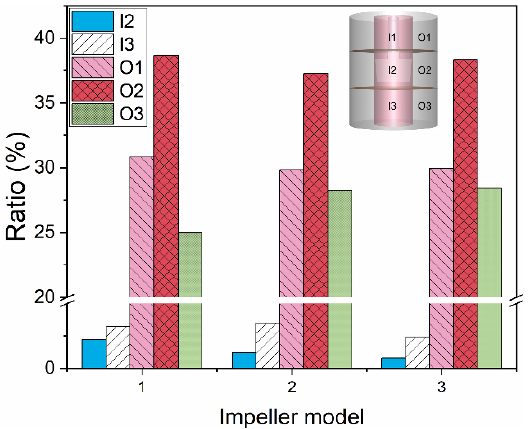
Figure 7. Particle distribution for the three impeller models in the ladle.